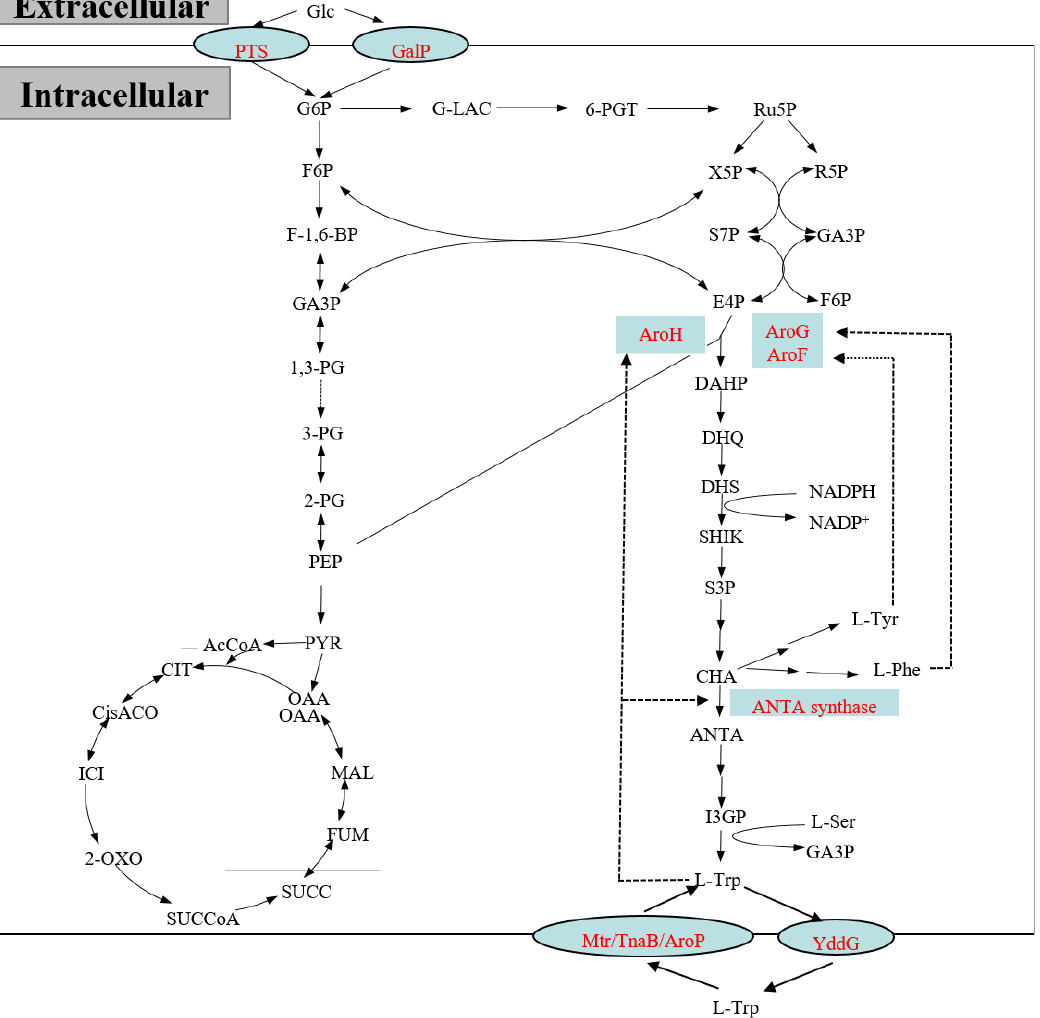
Figure 2. The metabolic pathway involved in L-tryptophan biosynthesis and its regulations in E. coli . The dashed lines indicate feedback inhibitions by the aromatic amino acid end products.